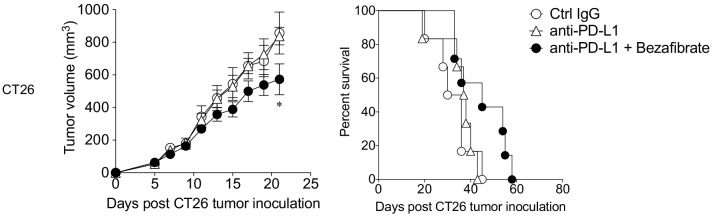
Enhancing mitochondrial activation by bezafibrate chemicals improves the anti-tumor effect for SIP-positive tumor in BALB/c background.SIP-positive CT26 tumor was injected in mice and therapy was given as per schedule mentioned in Figure 7B. Tumor size (left) and survival (right) of CT26 tumor-bearing host are shown. Data represent the means ± SEM of five mice. *p < 0.05, one-way ANOVA analysis. Data are representative of three independent experiments.